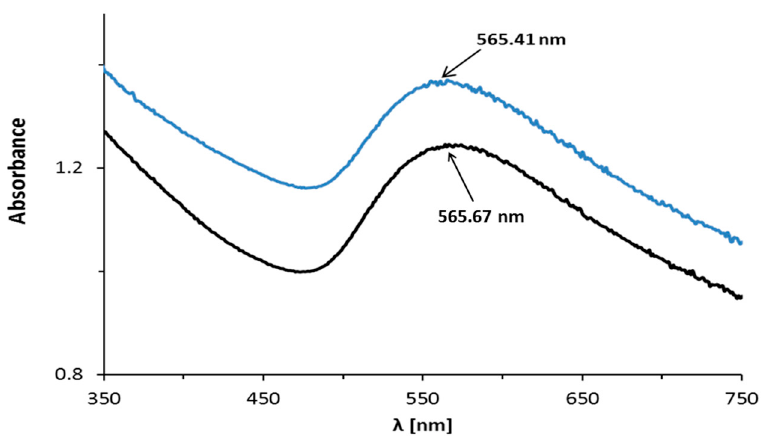
Figure 4. UV-Vis spectra of the AuNPs–AB conjugate in pH 7.4: the blue line denotes reaction mixtures; the black line denotes nanoparticle precipitate.